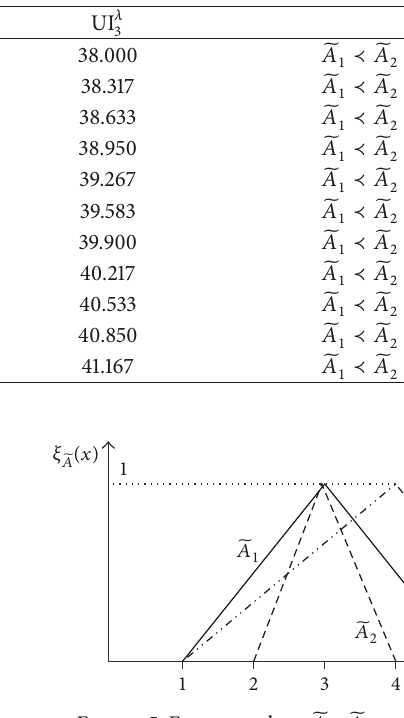
Table 3: Ranking results for Example 16.